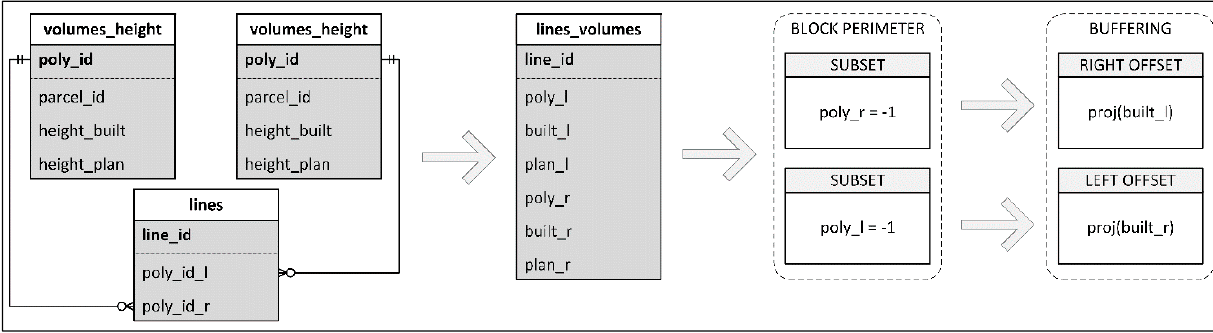
Figure 7. Diagram of the method to project the apparent occlusion onto the ground